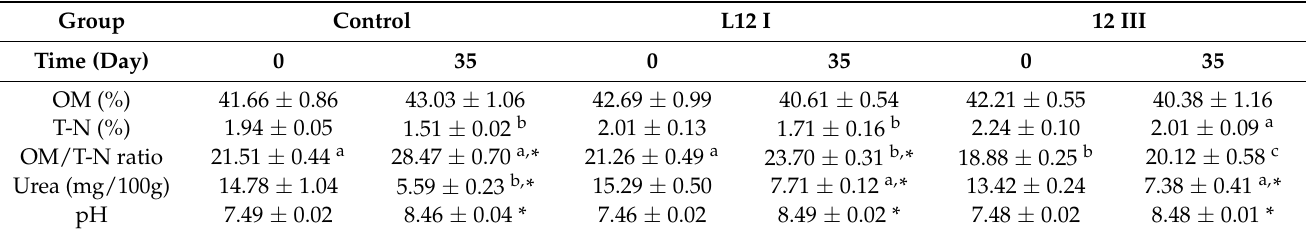
Values represent the mean ± S.E. ( n = 3). *: statistical significance compared with 0 and 35 days of each group ( p < 0.05) by using t -test. (a, b, c) letters: statistically significant difference between groups at the same day within a line ( p < 0.05) by using one-way ANOVA. OM, organic matter; T-N, total